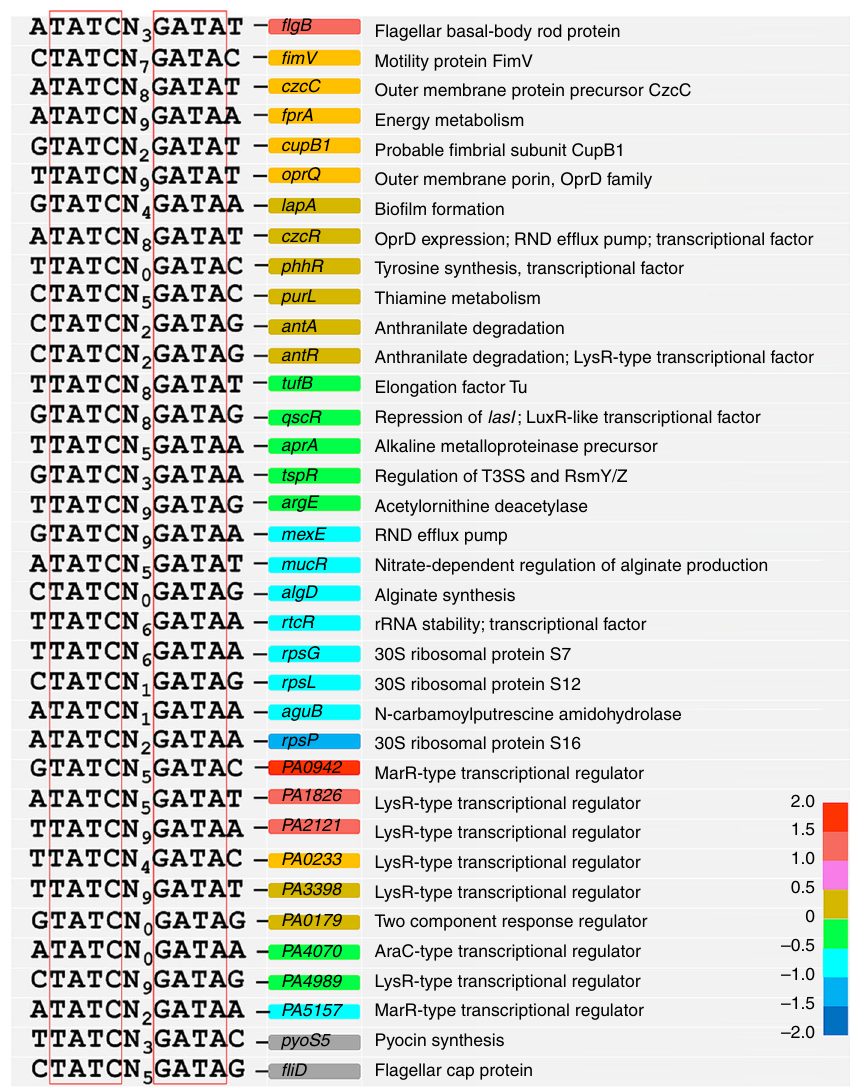
Fig. 8 Identi fi cation of SrpA-binding sites in bacterial genome. The SrpA-binding sequences (5 ′ -NTATCN(0,9)GATAN-3 ′ ) were searched across the draft genome sequence of PAK (http://www.pseudomonas.com/replicon/setmotif). Different colors depict the log2-transformed value of expression change folds of the indicated genes. Hypothetical regulators are represented with gene IDs, separated from the genes with known functions. No expression data is available for pysS5 and fl